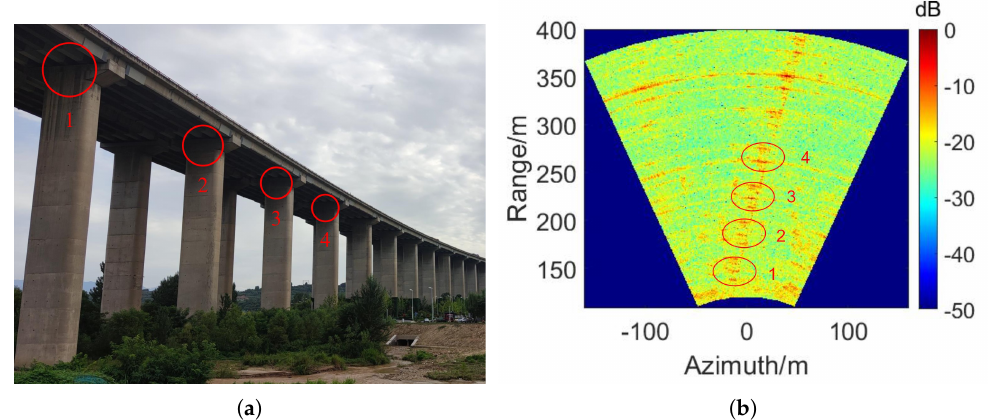
Figure 13. High-way bridge experiment scenario. ( a ) High-way bridge. ( b ) Imaging results.